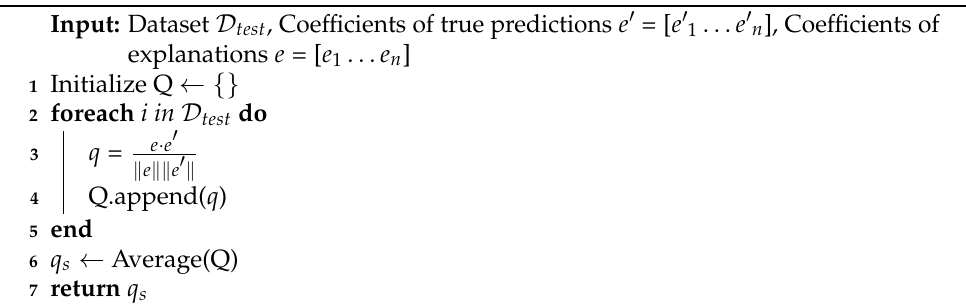
Algorithm 3: Quality of